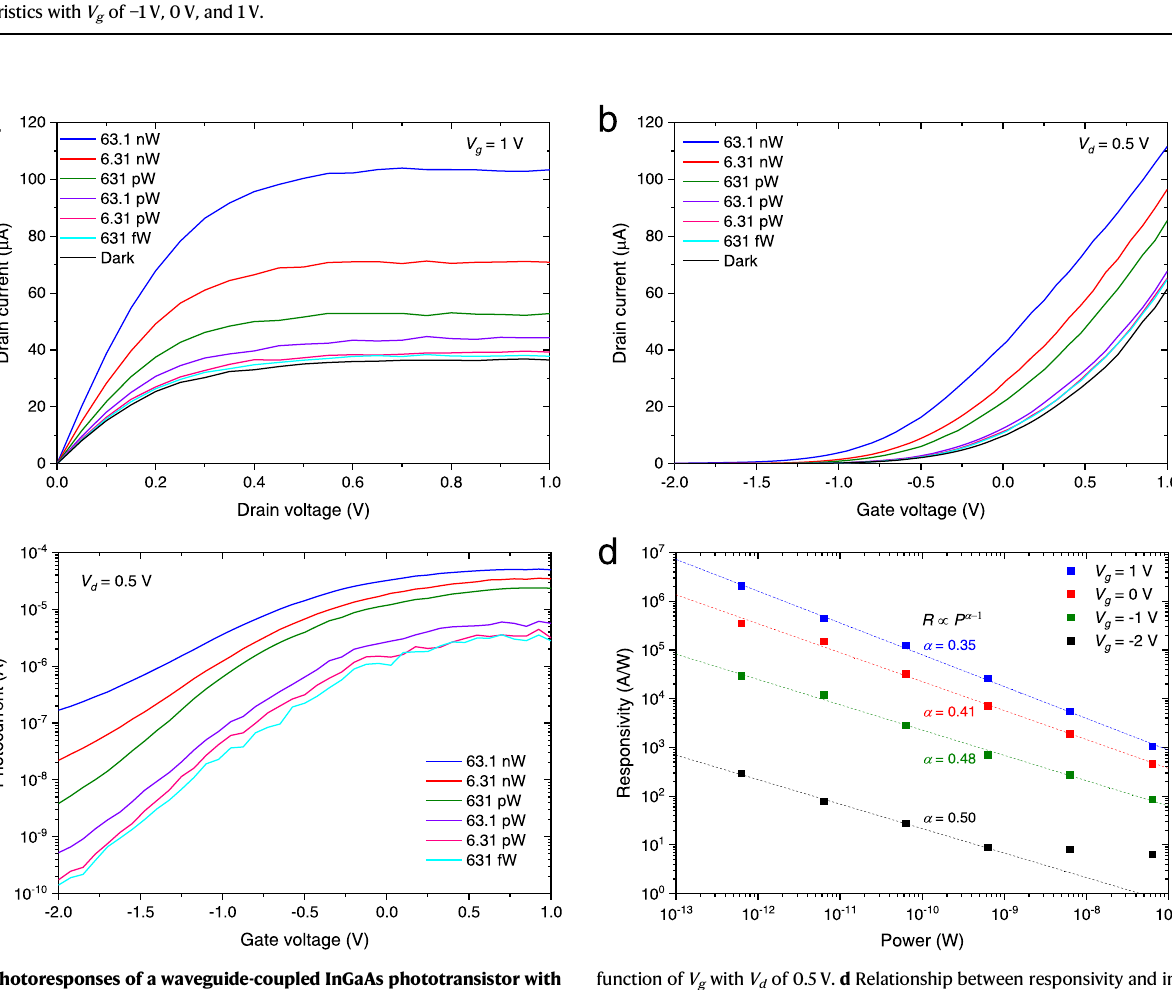
function of V g with V d of 0.5V. d Relationship between responsivity and input power at various gate